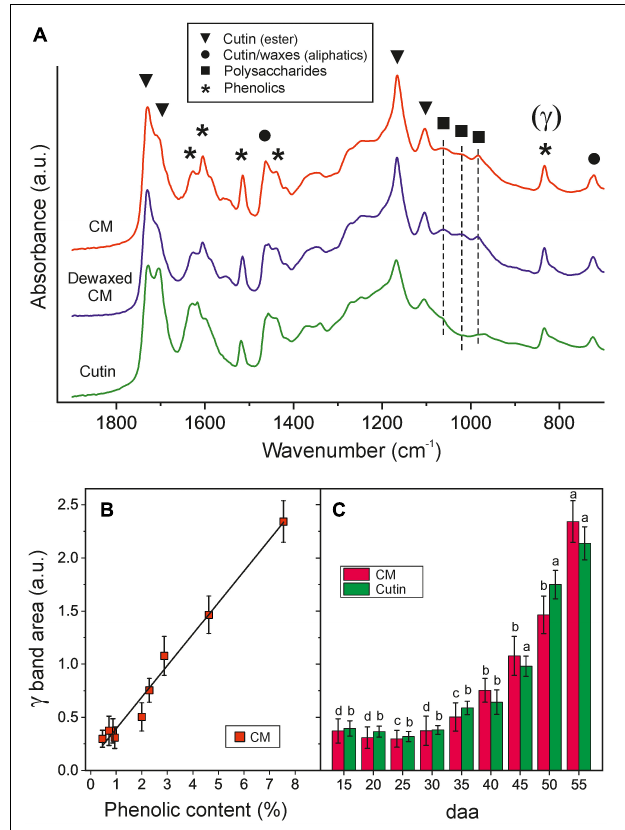
FIGURE 2 | (A) ATR-FTIR spectra of isolated and dewaxed CMs and cutins of ripe tomato fruit. Characteristic bands of cutin, polysaccharides, waxes and phenolics are labeled with symbols. (B) Correlation between the phenolics content and the ATR-FTIR γ band area in cuticle membranes. (C) Evolution of phenolics content by means of the ATR-FTIR γ band area in tomato CMs and cutins along fruit growth and ripening. Error bars represent ± 1 SE and letters indicate significant differences ( P <